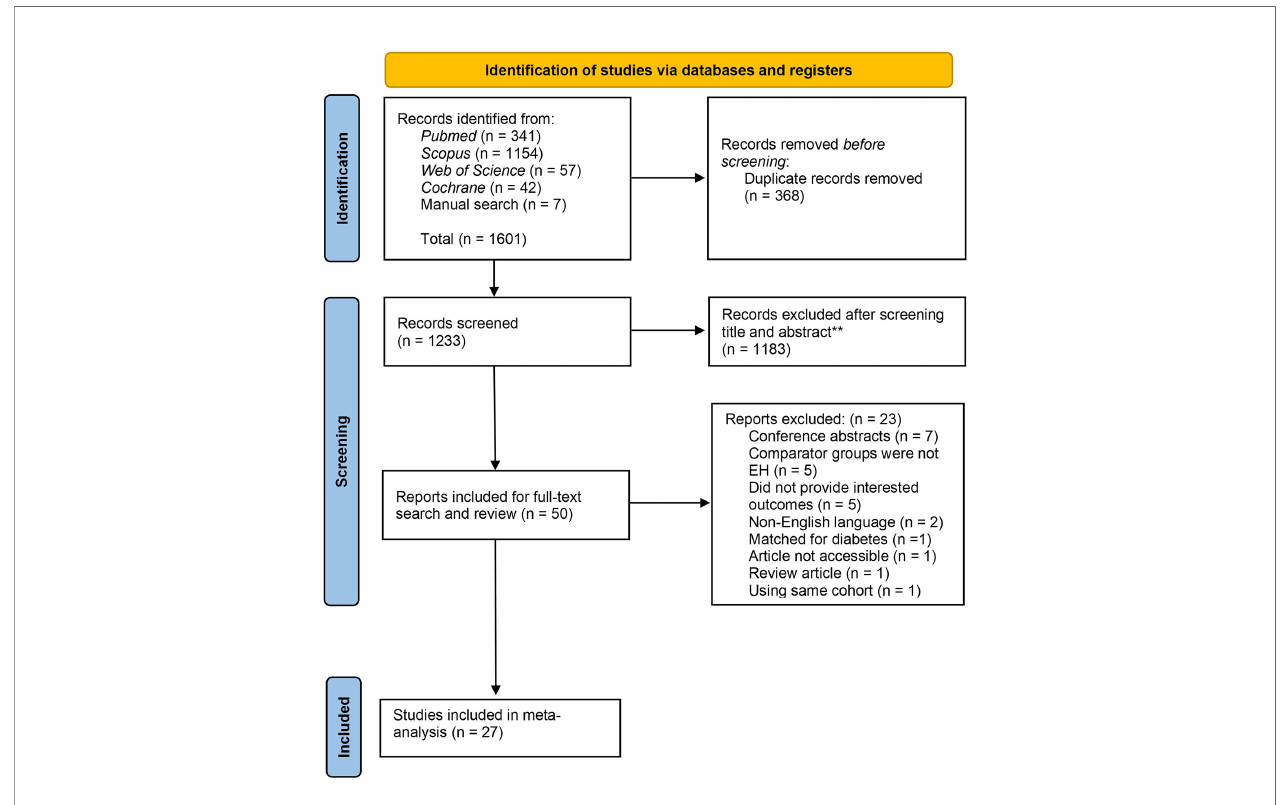
FIGURE 1 | PRISMA fl ow